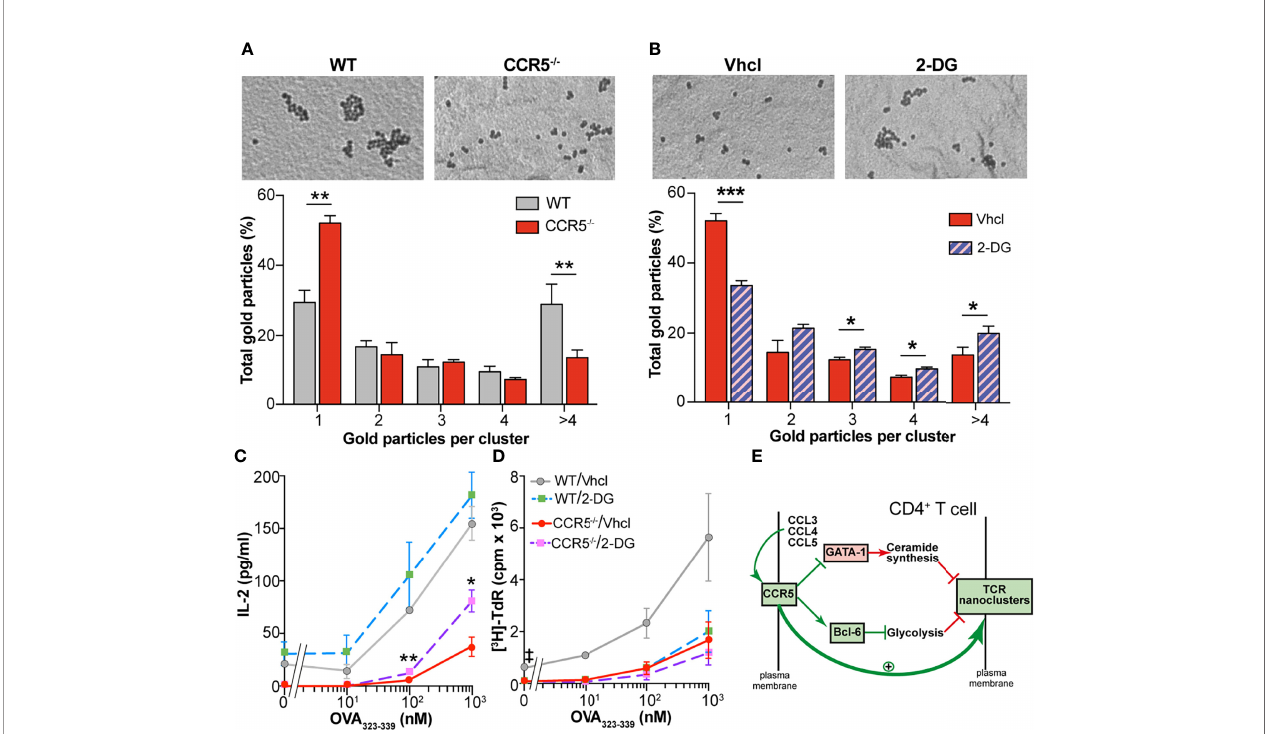
FIGURE 5 | Inhibition of glycolysis increases TCR nanoclustering in CCR5 -/- cells. (A) Analysis of TCR nanoclustering by EM in OT-II WT and CCR5 -/- lymphoblasts (WT, n =5 cells, 11,339 particles; CCR5 -/- , n =5 cells, 9,347 particles). Top: A representative small fi eld image shows gold particle distribution in the cell surface replicas of anti-CD3 ϵ -labeled cells. Bottom: quanti fi cation (means ± SEM) of gold particles in clusters of the indicated size in WT (gray) and CCR5 -/- cells (red). (B) OT-II CCR5 -/- lymphoblasts were expanded in the presence of IL-2 (see Figure 1A), and incubated with the glycolysis inhibitor 2-DG over the last 24 h of expansion (day 7). Lymphoblast surface replicas were stained with anti-CD3 ϵ and TCR nanoclustering analyzed by EM. Top: representative small fi eld images show gold particle distribution in the cell surface replicas. Bottom: quanti fi cation (means ± SEM) of gold particles in clusters of the indicated size in vehicle- (solid red; n =5, 9,347 particles) and 2-DG-treated cells (hatched violet; n =5, 11,993 particles). Data are means ± SEM. ***p < 0.001, **p < 0.01, *p < 0.05 one-tailed Student t test (A, B) . (C, D) OT-II WT and CCR5 -/- lymphoblasts were incubated with 2-DG over the last 24 h of expansion, washed extensively to remove the inhibitor, and then co-cultured with irradiated splenocytes previously loaded with the OVA 323-339 peptide. IL-2 (C) and cell proliferation (D) were determined after 24 h of re-stimulation- Data are means ± SEM ( n =3). **p<0.01, *p<0.05 (for comparisons between Vhcl- and 2-DG-treated CCR5 -/- cells), ‡ p < 0.05 (for comparisons between Vhcl- and 2-DG-treated WT cells); two-tailed Student t test with Holm-Sidak correction for multiple comparisons. (E) Model proposed for the regulation of TCR nanoclustering by CCR5. It is here proposed that autocrine/paracrine activation of CCR5 fosters TCR nanoclustering by triggering two independent signals in CD4 + T M cells: (i) the inhibition of GATA-1 translocation into the nucleus, and (ii) the stabilization of the glycolytic repressor Bcl-6. More details are available in the